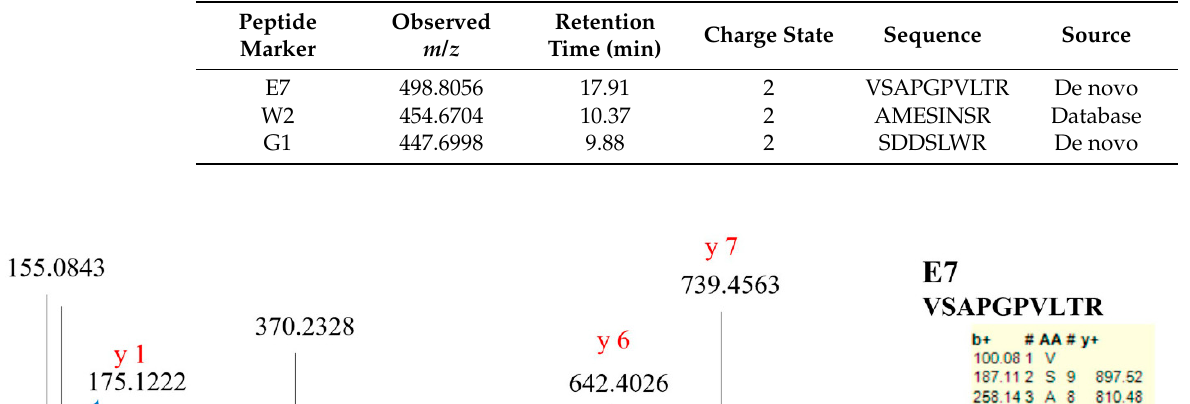
Table 2. The peptide markers identified by database searching and de novo sequencing.